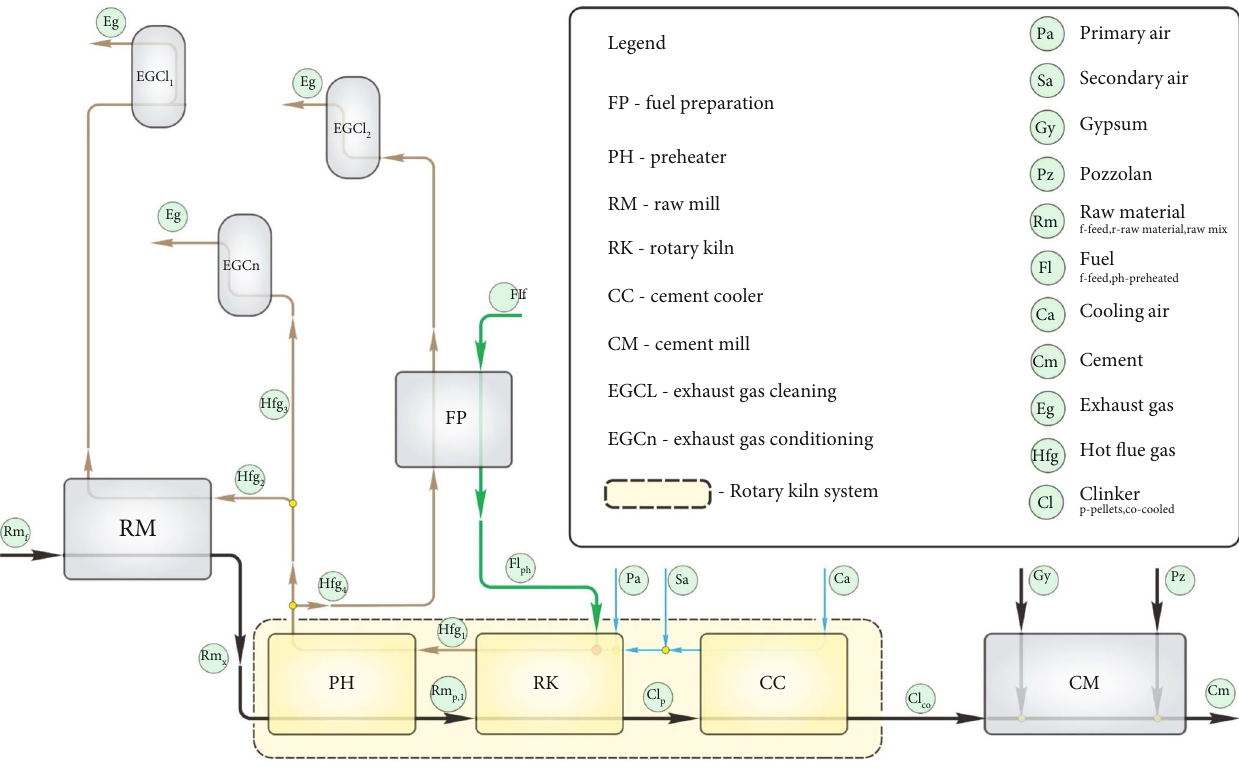
Figure 2: Simpli fi ed block fl ow diagram (BFD) of the MCC